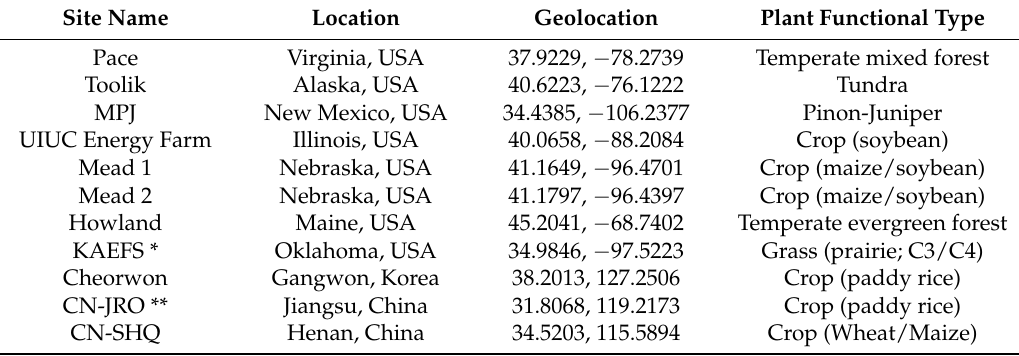
Table 1. SIF Network (FluoNET): site names, coordinates, and plant functional types (PFTs). * Kessler Atmospheric and Ecological Field Station ** Jurong Agricultural Ecosystem